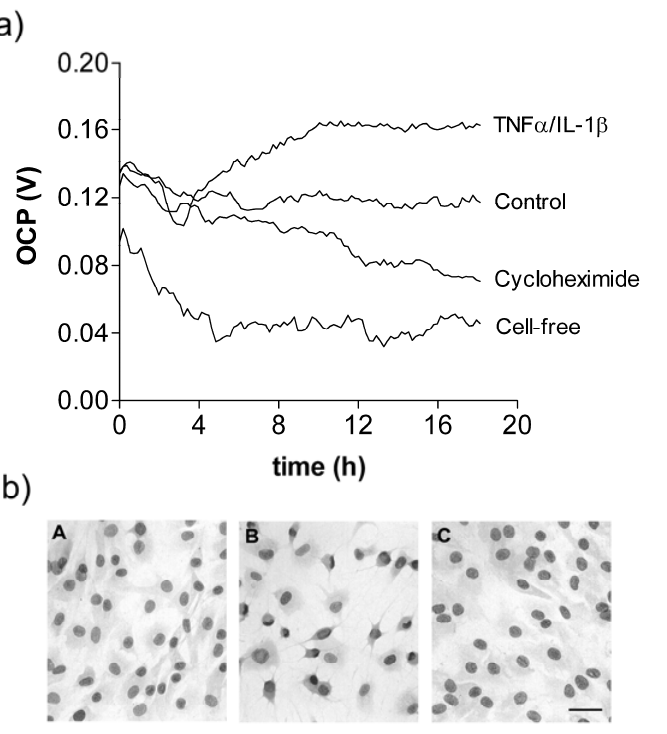
Figure 4. (a) Real-time monitoring of the OCP of rheumatoid synovial fibroblasts showing the effects of cycloheximide and TNF α /IL-1 β (mean values from 6 sensors for each treatment). (b) Photomicrographs showing the morphology of control (A), TNF α /IL-1 β (B) and cycloheximide (C) -treated cells after 18h. Bar = 20